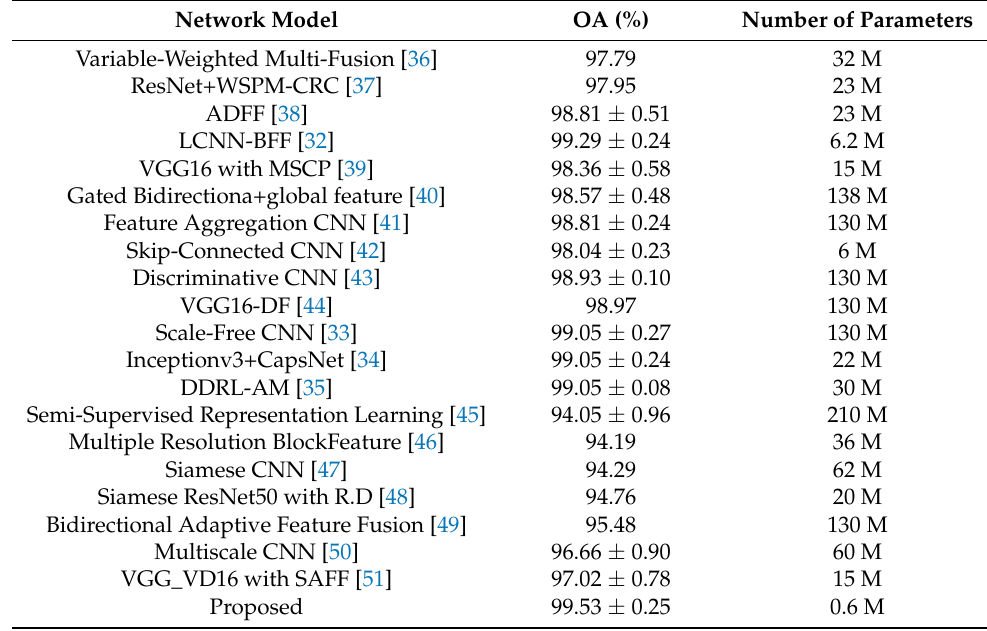
Table 2. Comparison of OA and parameters between the proposed method and some advanced methods on the UCM dataset with 80% training ratio.